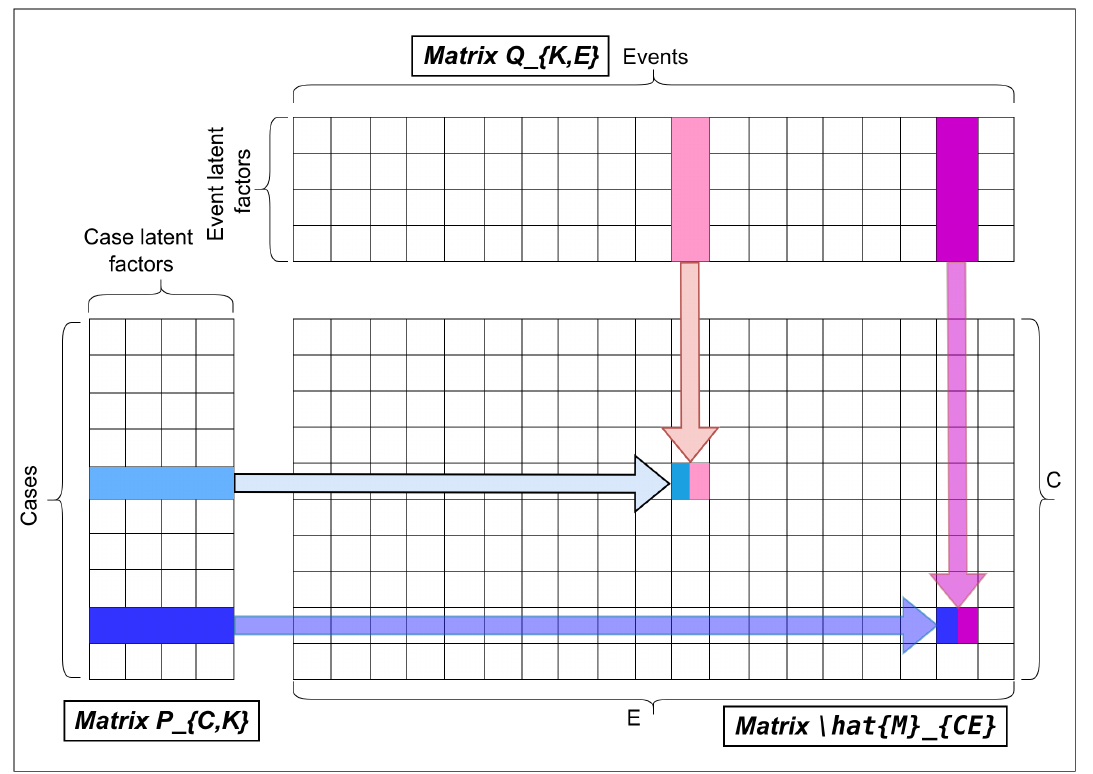
Figure 2. Decomposition diagram of the case–event